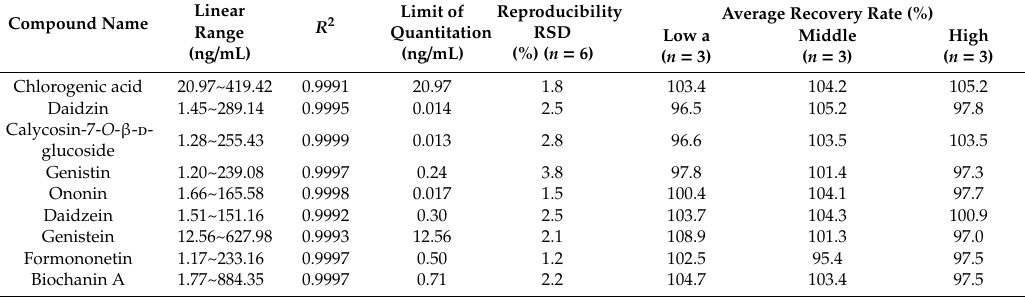
Figure 3. MRM (multiple reaction monitoring) chromatograms of the nine compounds detected in samples. ( A ): Chlorogenic acid; ( B ): daidzin; ( C ): calycosin-7- O - β - d -glucoside; ( D ): genistin; ( E ): ononin; ( F ): daidzein; ( G ): genistein; ( H ): biochanin A; ( I ): formononetin. Table 1. Results of the method validation for the nine compounds detected in red